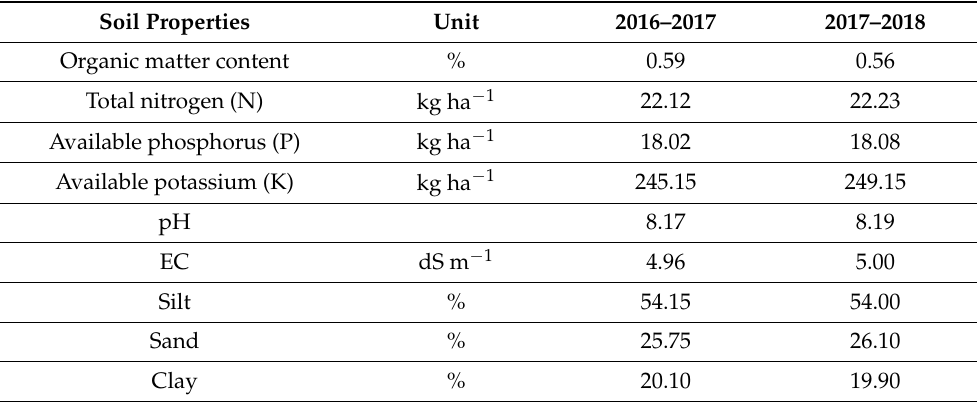
Table 1. Physicochemical characteristics of the soil in the experimental area before the initiation of the experiments.